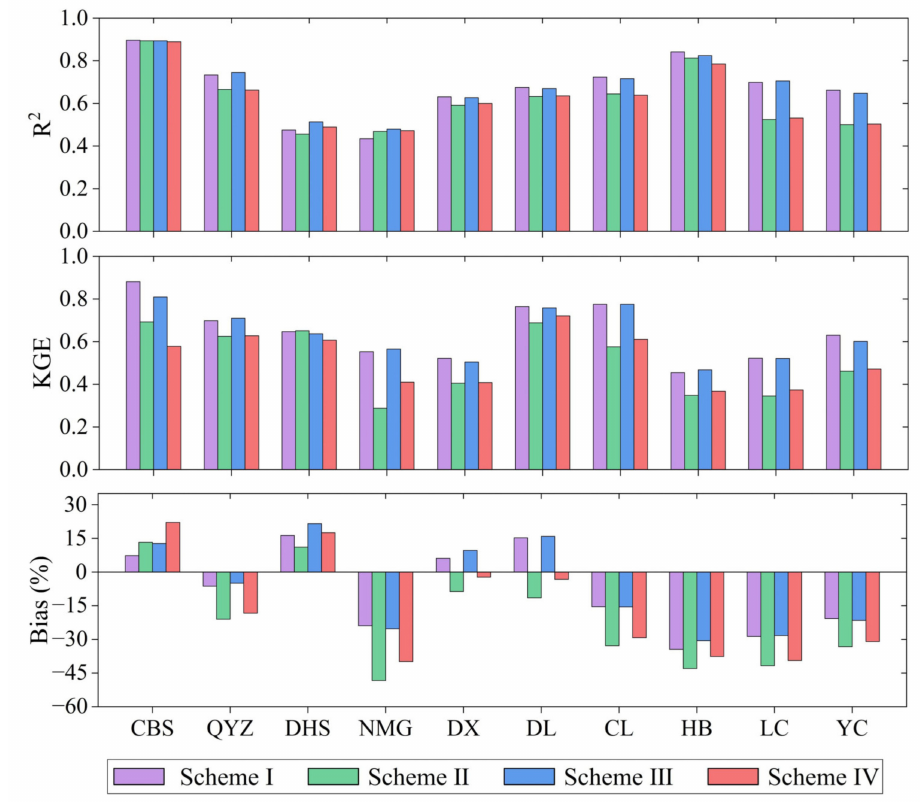
Figure 7. Comparison of the performance of the PT-JPL model at ten flux sites under the four schemes.